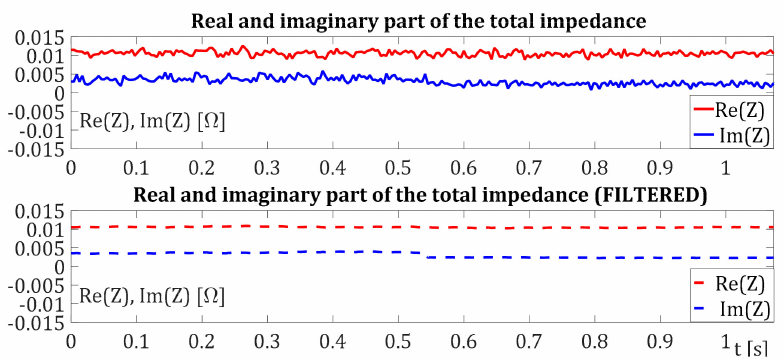
Figure 11. Experimental results for the real and imaginary part of the total impedance during voltage test signals.